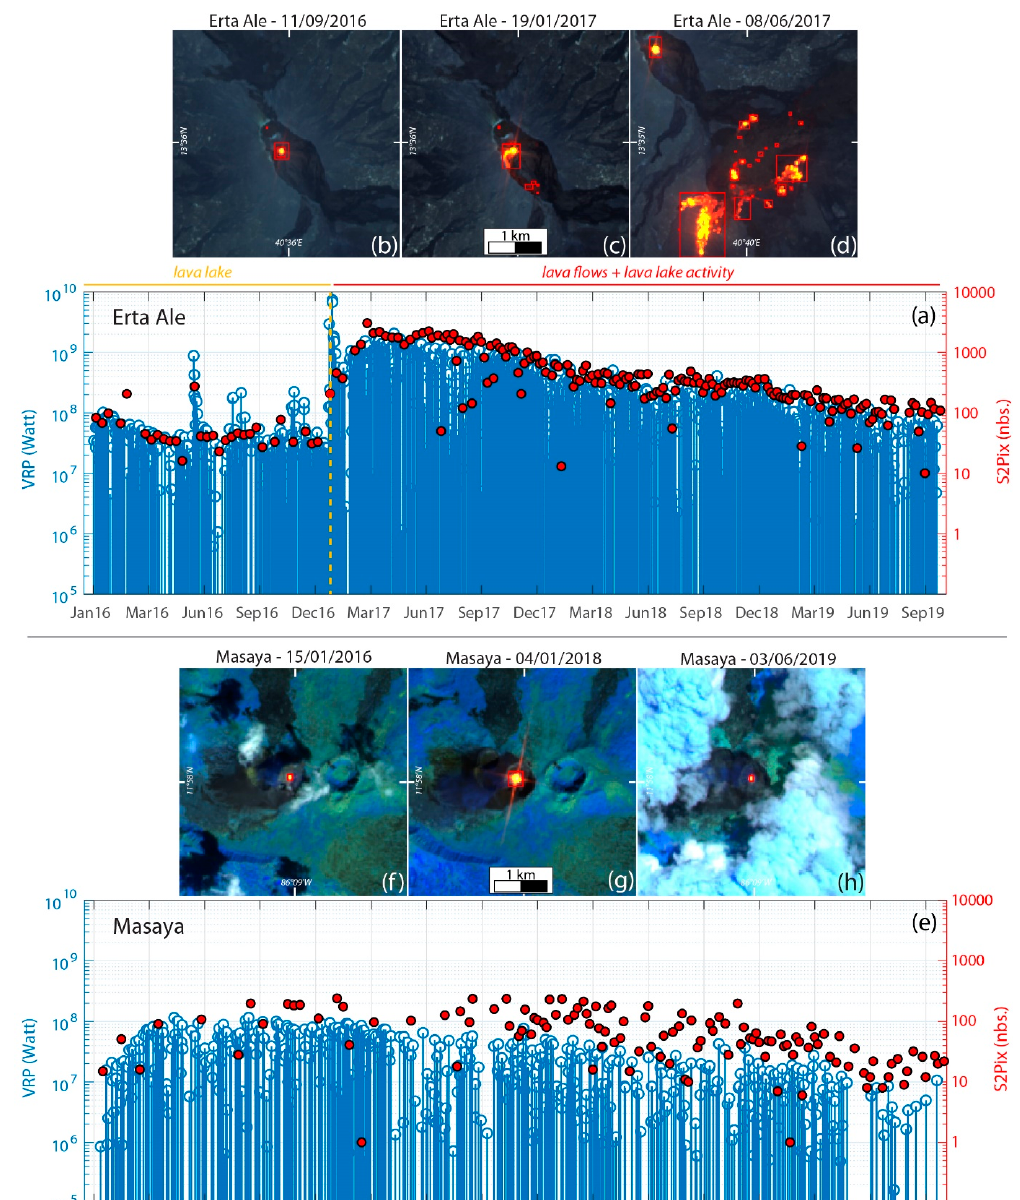
Figure 9. S2Pix and VRP–MIROVA thermal comparison on Erta Ale and Masaya lava-lake-type case studies. In ( a , e ), y-logarithmic timeseries. With blue stem on left y-axis, MIROVA VRP heat flux in Watt; with red dots on right y-axis, the S2Pix. Yellow dotted line in ( a ) distinguishes the lava-lake activity to the lava-flows periods at Erta Ale. In ( b – d ), particulars of thermal emissions and lava flows over Erta Ale area. In ( f – h ), particulars of thermal emissions and lava-lake activity of Masaya.